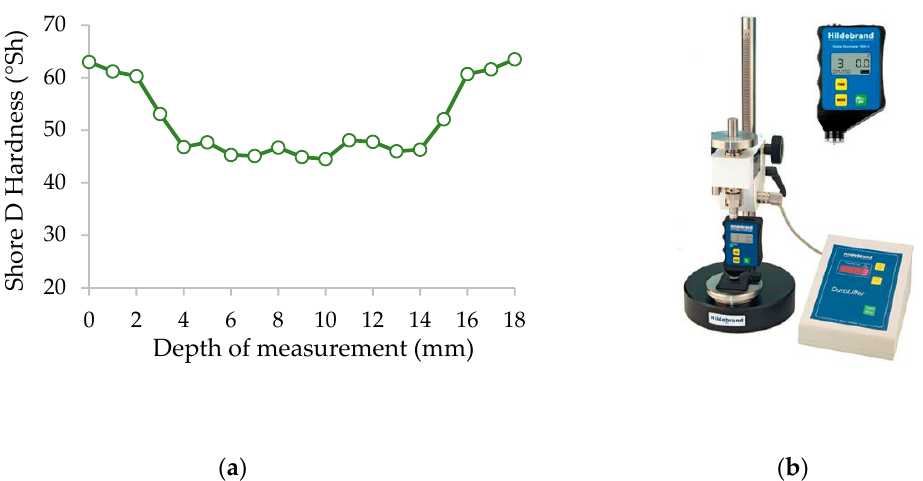
Figure 2. Hardness measurement: ( a ) Hardness profile of MDF used in tests; ( b ) shore hardness tester.